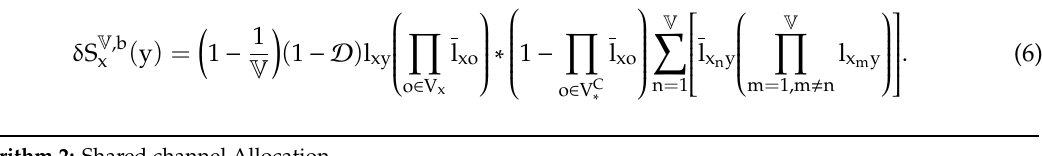
Algorithm 2: Shared channel